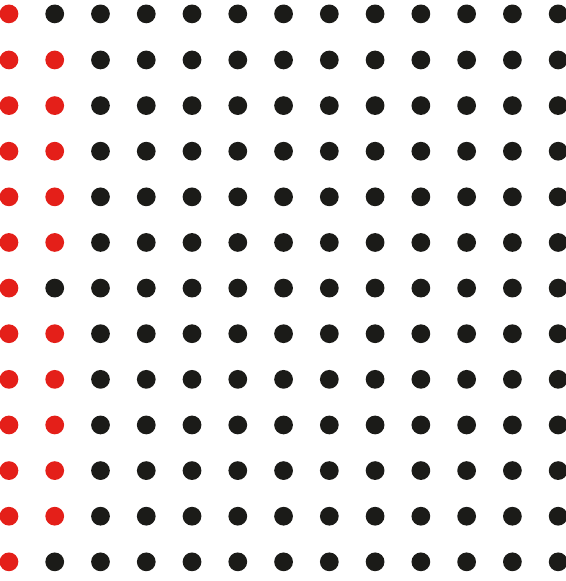
Figure 26: Schematic diagram of uplifted nodes under Taft wave for HV case (23 nodes uplifted and uplift area ratio is 5.6%).